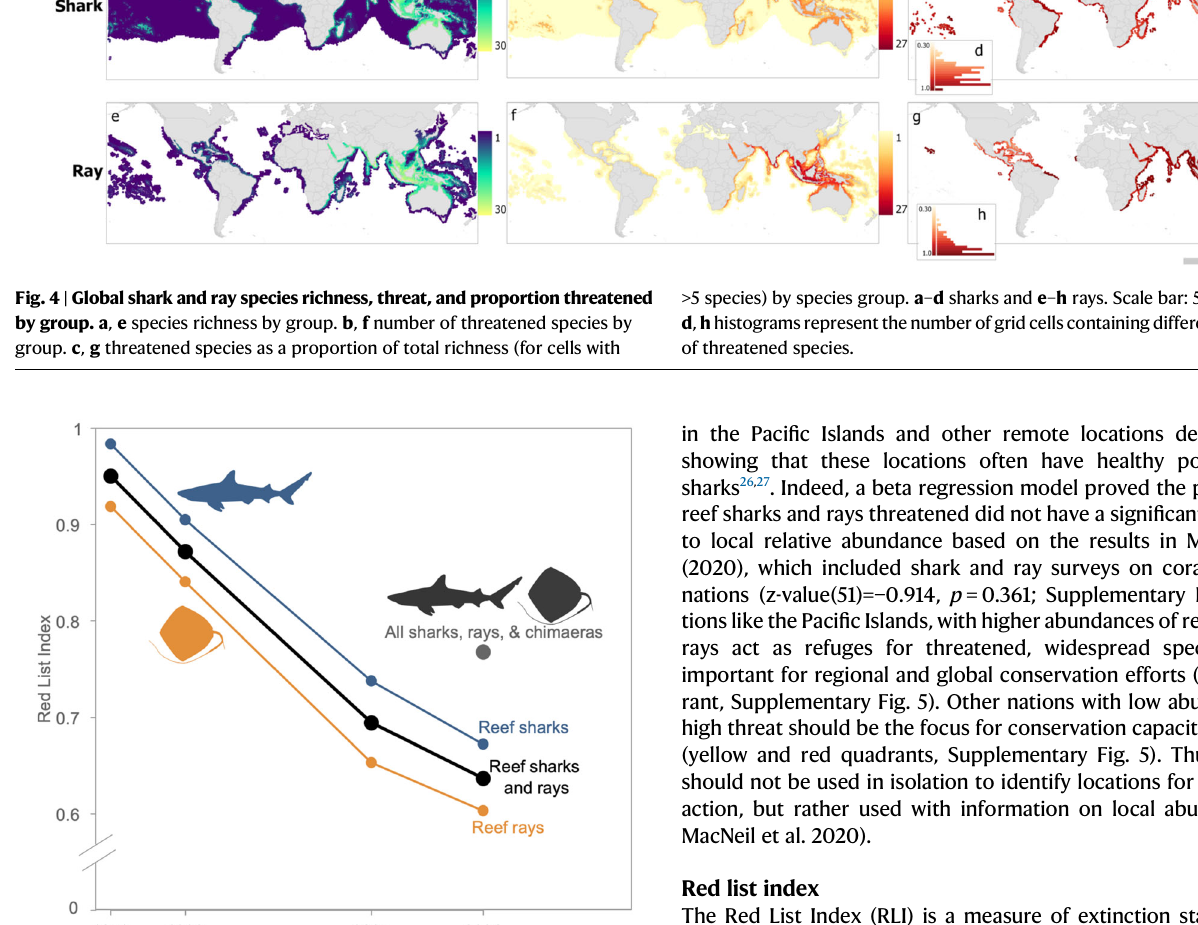
Fig.5|Increaseinextinctionriskofcoralreefsharksandraysoverthepasthalf century. GlobalRed List index (RLI) for the 125 data-suf fi cient reef sharks and rays combined, and each separately, estimated in 1970, 1980, 2005, and 2021, and comparedtotheRLIforallsharkandrayspecies.AnRLIvalueof1indicatesthatall speciesinthetaxaareLeastConcernandanRLIvalueof0indicatesthatallspecies are Extinct. Source data are provided as a Source Data fi